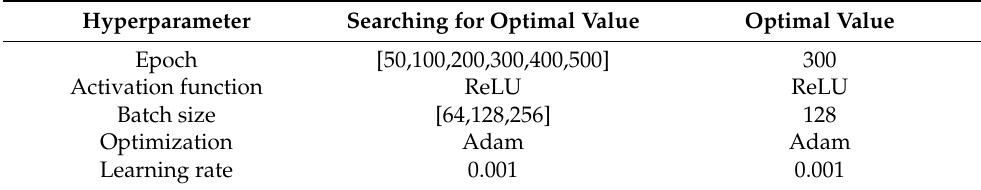
Table 2. The hyperparameters used in designing the LSTM